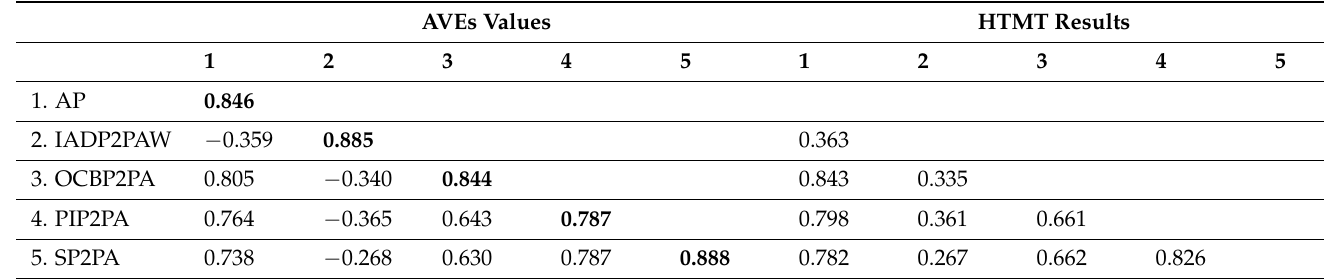
Table 3. Inter-construct correlations, the square root of AVE, and HTMT results.